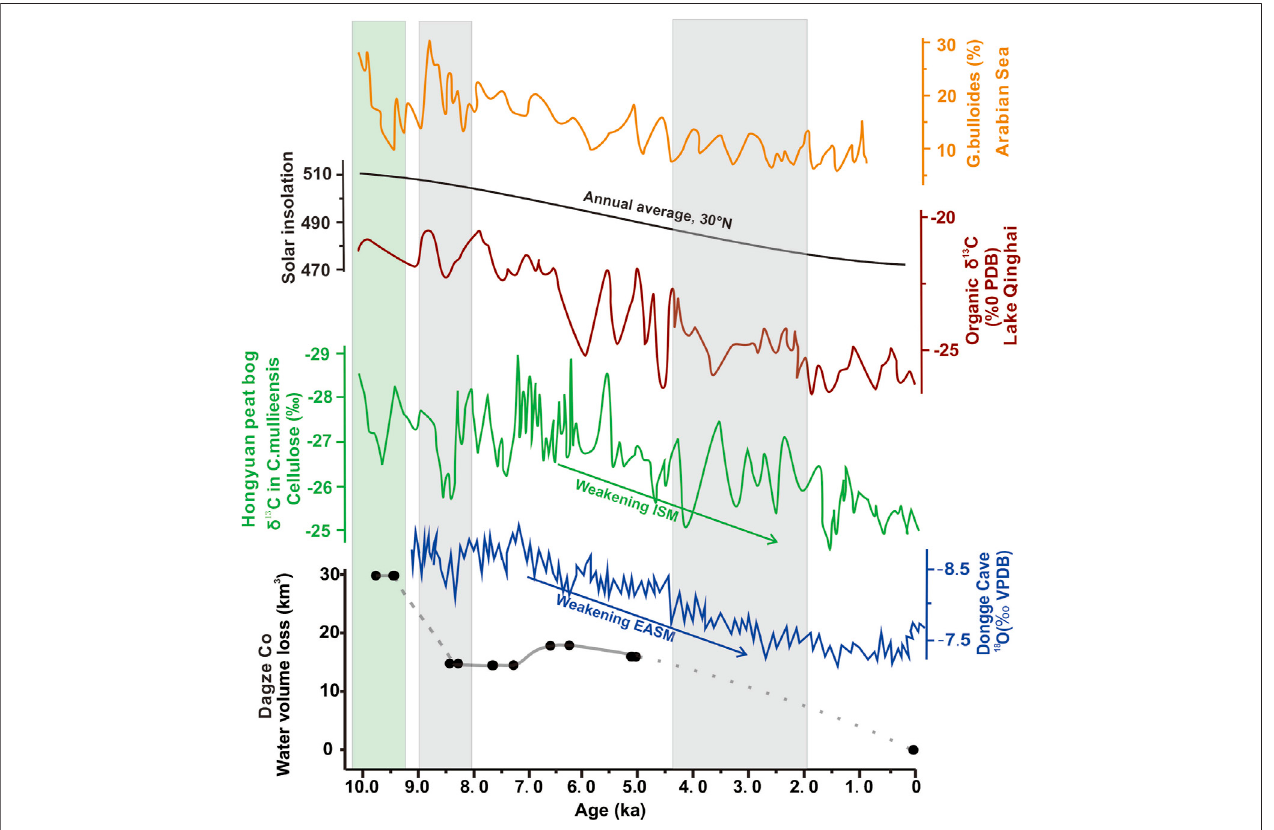
FIGURE 6 | Changes in lake volume of Dagze Co since the early Holocene and other related climatic proxies: G. bulloides proxy record from Arabian Sea (Guptaet al.,2003),summersolarinsolation at30 ° N(BergerandLoutre,1991),proxyrecordsfromQinghaiLake (Jietal.,2005), δ 13 Crecordsfrom Hongyuanpeatbog (Hong et al., 2003), and oxygen isotope records in the stalagmite from Dongge Cave (Wang et al., 2005).